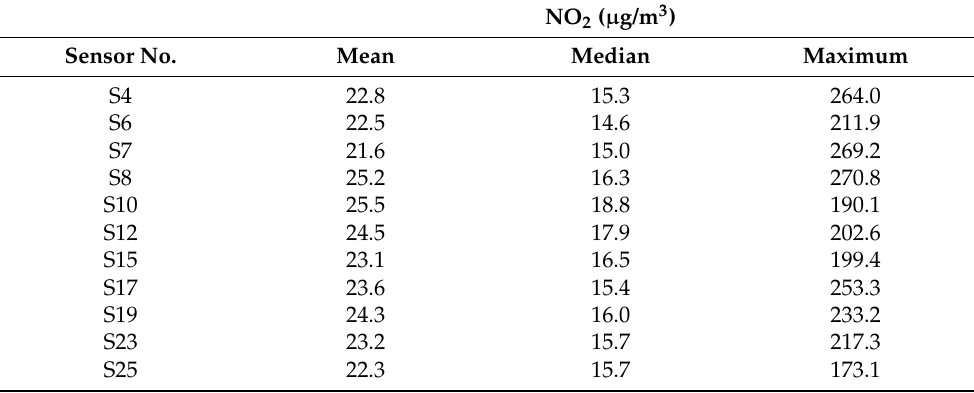
Table 8. Average hourly values of NO 2 concentration recorded over the 1-year monitoring period.